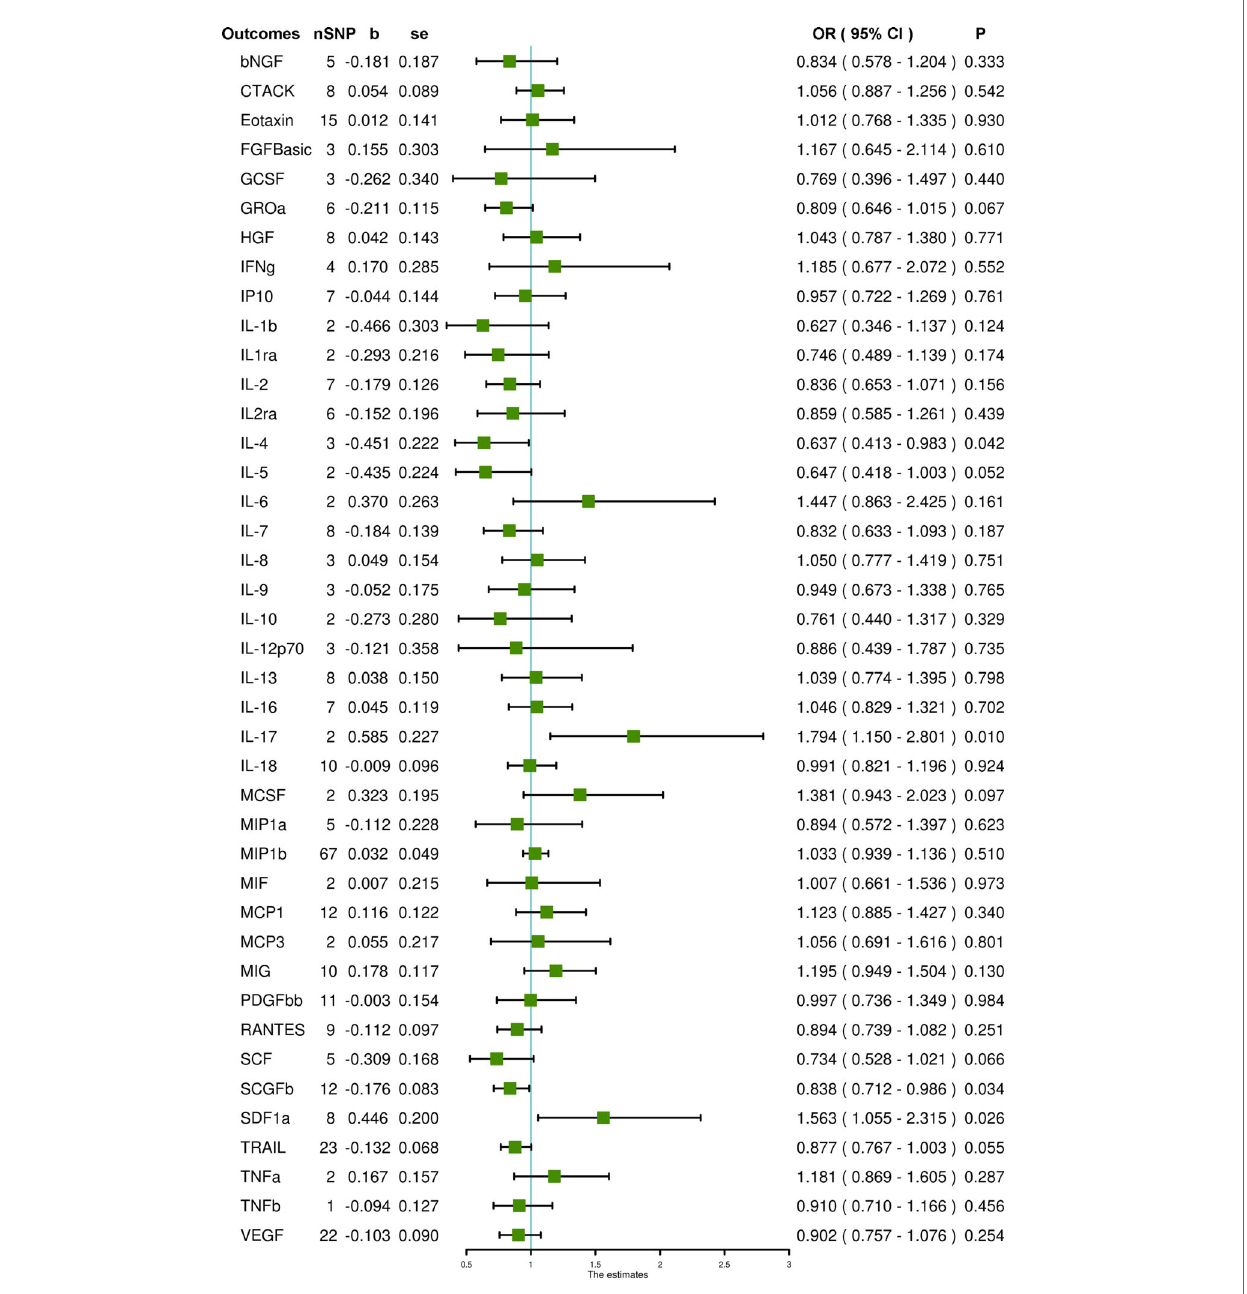
Frontiers in Endocrinology |